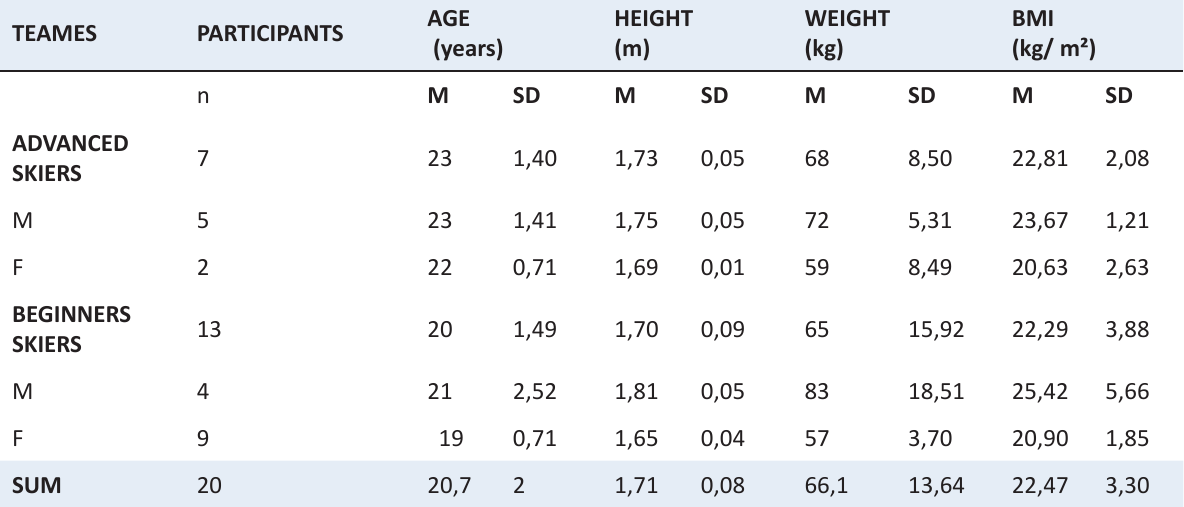
Table 2. Determination of the simulator’s rubber tape elongation force (every 10cm) Number of part (range of part)